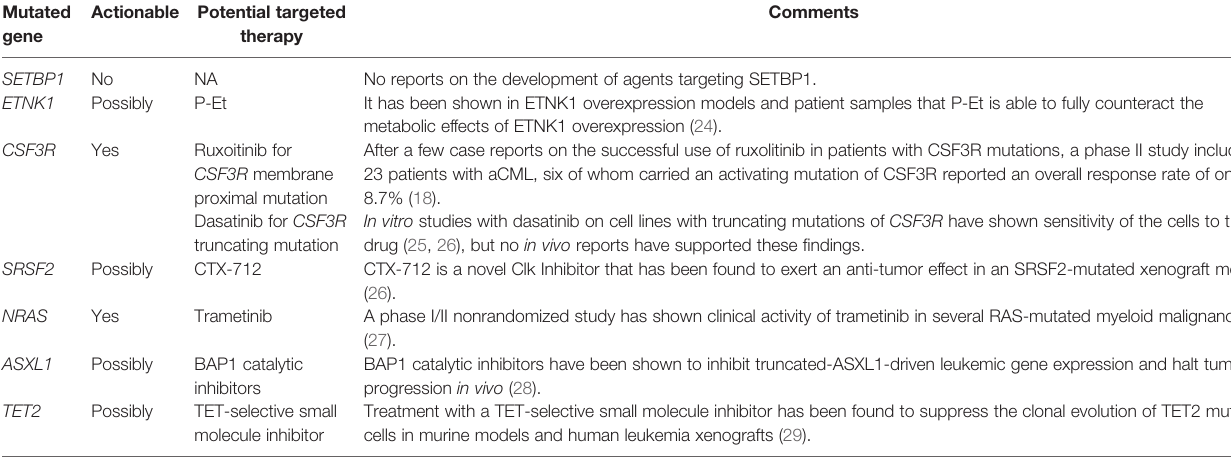
TABLE 3 | Actionable and non-actionable mutations in